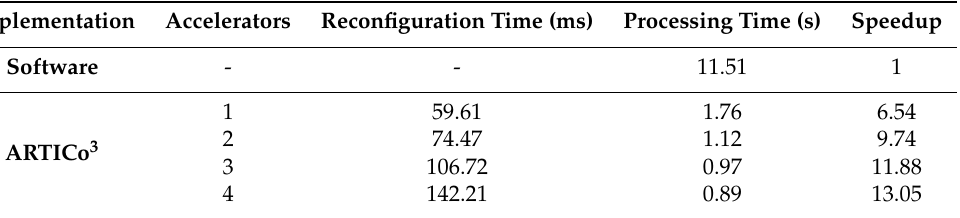
Table 7. Matrix multiplication: performance metrics.